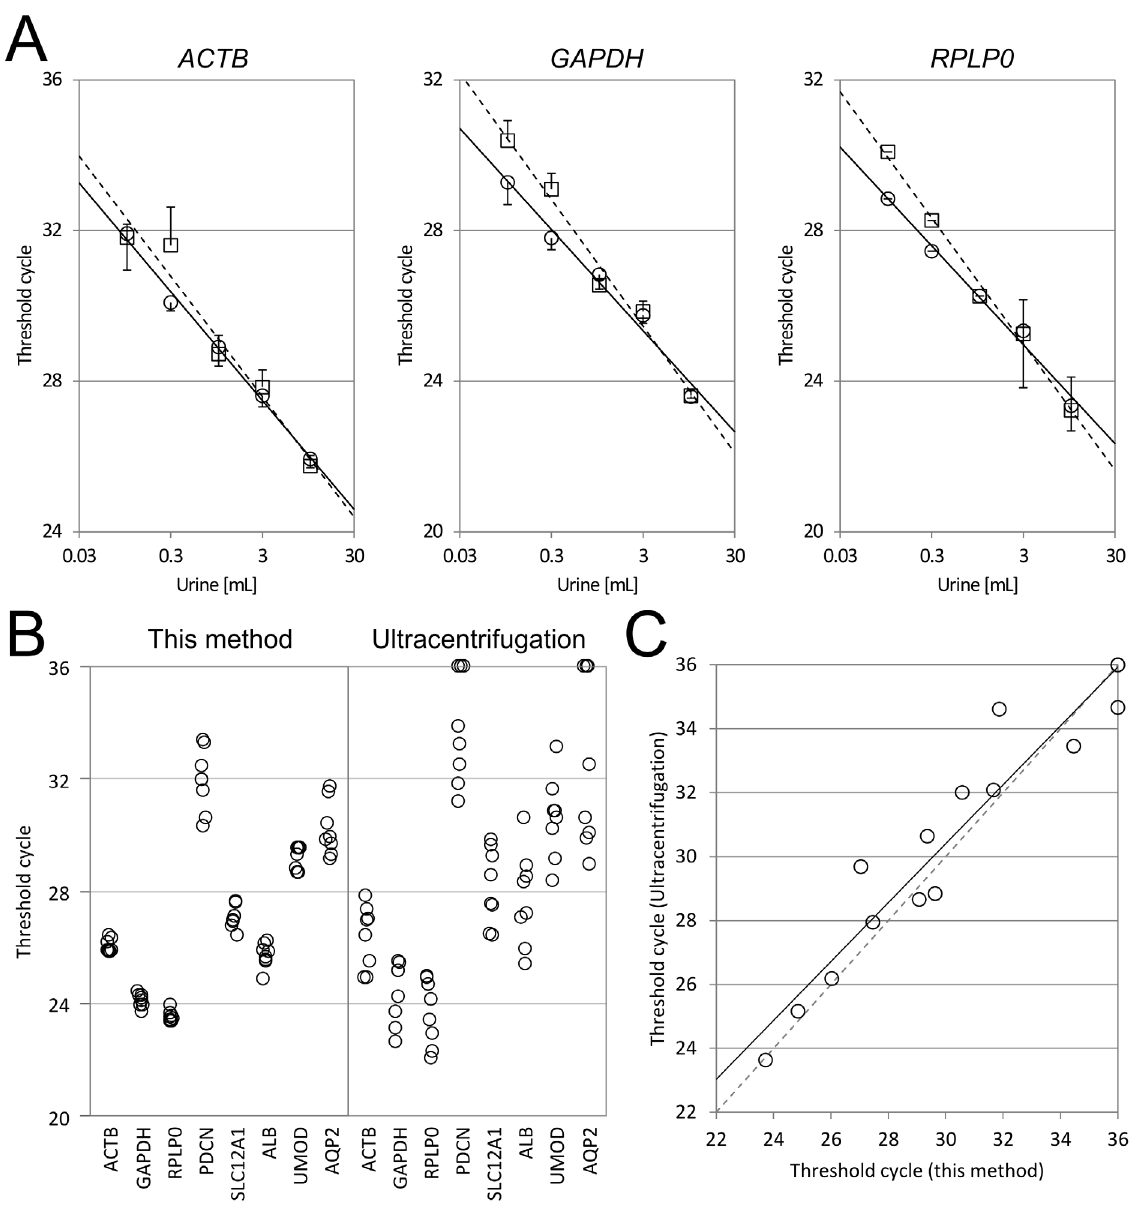
Figure 5. Performance Comparison with Standard Ultracentrifugation Method. A. Assay Linearity Comparison. A spot urine sample was obtained from a healthy donor. One hundred m L to ten mL of the urine sample were processed by EMV capture device ( # ) or the standard ultracentrifugation method ( % ) and ACTB , GAPDH and RPLP0 were quantified in triplicate as described in Materials and Methods. Mean Ct values were plotted and error bars are standard deviations. Solid and perforated lines are linear regression curves of exosome collection device and the standard ultracentrifugation method, respectively. Their formulas are; [ ACTB ] EMV capture device: y= 2 2.89 x + 28.87 (R 2 =0.994) and ultracentrifugation: y= 2 3.19 x + 29.12 (R 2 =0.956), [ GAPDH ] EMV capture device: y= 2 2.69 x + 26.63 (R 2 =0.980) and ultracentrifugation: y= 2 3.36 x + 27.07 (R 2 =0.983), and [ RPLP0 ] EMV capture device: y= 2 2.62 x + 26.23 (R 2 =0.987) and ultracentrifugation: y= 2 3.35 x + 26.59 (R 2 =0.993). B. Intra-assay Reproducibility Comparison. A spot urine sample was obtained from a healthy donor. Eight 10-mL replicates of the urine sample were processed by EMV capture device (left) or the standard ultracentrifugation method (right) and 8 genes ( ACTB , GAPDH , RPLP0 , PDCN , SLC12A1 , ALB , UMOD , AQP2 ) were quantified as described in Materials and Methods. Raw Ct values are available in Table S2. C. mRNA Profile Comparison. A spot urine sample was obtained from a healthy donor. Ten mL each of the urine sample was processed by EMV capture device or the standard ultracentrifugation method and 15 genes ( NPHN , PDCN , SLC12A1 , ALB , UMOD , AQP2 , ACTB , GAPDH , RPLP0 , PPIA , PGK1 , B2M , HPRT1 , GUSB1 , TBP ) were quantified in triplicate as described in Materials and Methods. Mean Ct values of the ultracentrifugation method were plotted against those of EMV capture device. The solid line is linear regression curve and its formula is y=0.922 x + 2.748 (R 2 =0.914). The perforated line is a diagonal line to indicate a perfect match of RNA profiles. of UMOD mRNA in urine may allow monitoring tubular act as inhibitor of calcium crystallization and defense against urinary tract infections. As the most abundant urinary protein secretion function. Although urinary albumin is mainly leaked produced by the thick ascending limb of the Henle loop, detection from blood into urine due to abnormal renal glomerulus and used